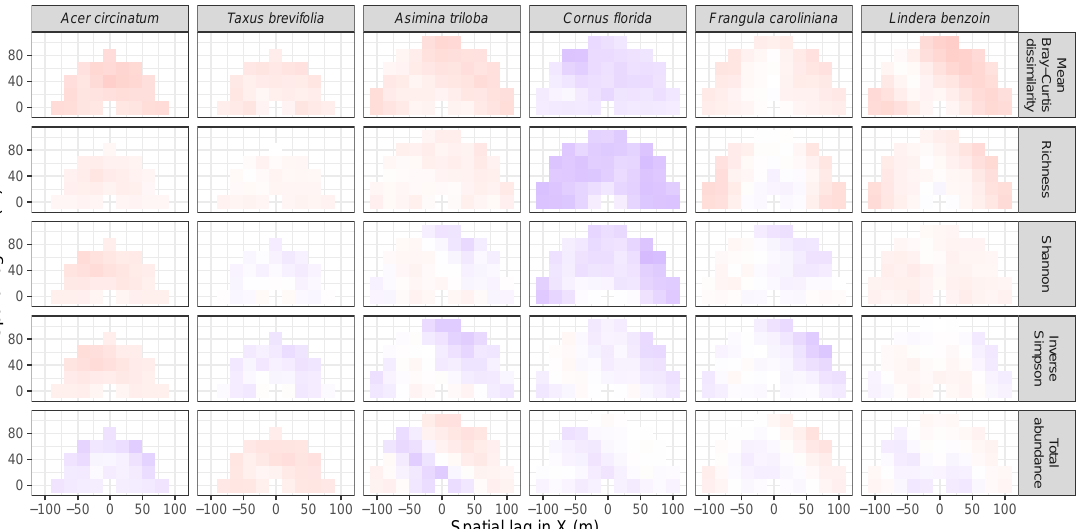
Figure A6. Codispersion between measures of diversity and total basal area of the focal understory species in 20 20-m subplots in the 25.6-ha Wind River ( Acer circinatum, Taxus brevifolia ) and 20-ha Tyson Research Center ( Asimina triloba, Cornus florida, Frangula caroliniana, Lindera benzoin ) plots. Codispersion coefficients were calculated for spatial lags ranging from 0–80 m (WR) and 0–105 (TY) at 20-m intervals. The value of the codispersion coefficient can range from − 1 (dark blue) through 0 (white) to 1 (dark red). Statistical significance of each codispersion coefficient is shown in Figures A7 and A8.